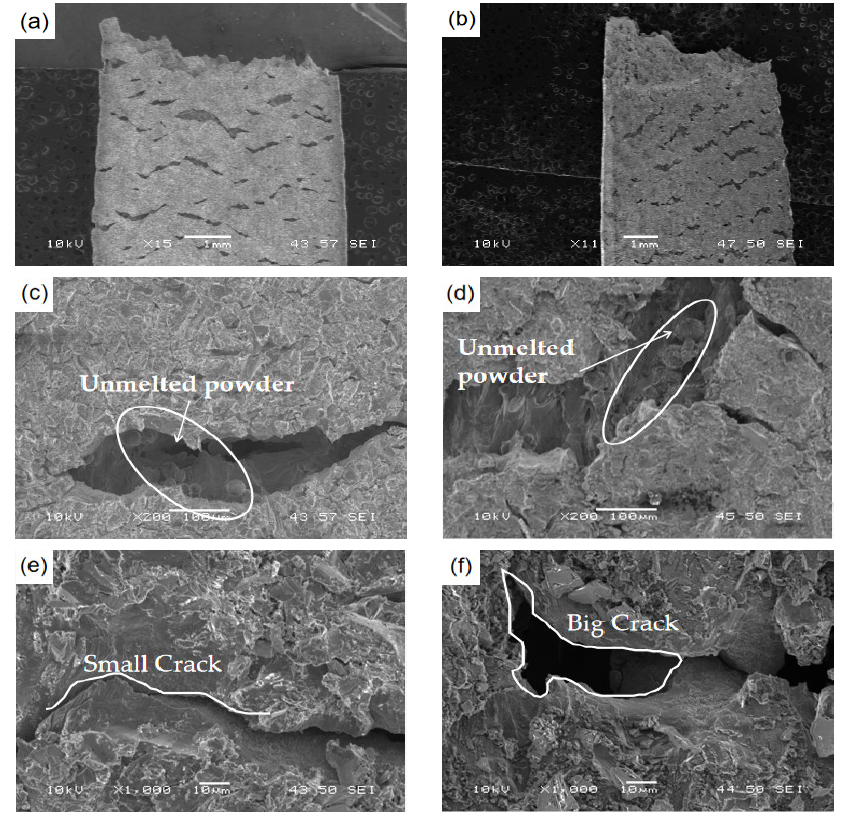
Figure 12. Surface photo of the sample after tensile test: ( a ) overall appearance of the flat-printed sample after stretching; ( b ) overall appearance of the vertically printed sample after stretching; ( c ) particles in the crack of the flat-printed sample; ( d ) particles in the cracks of the vertically printed sample; ( e ) crack morphology of the flat-printed sample; ( f ) crack morphology of the vertical- printed sample.